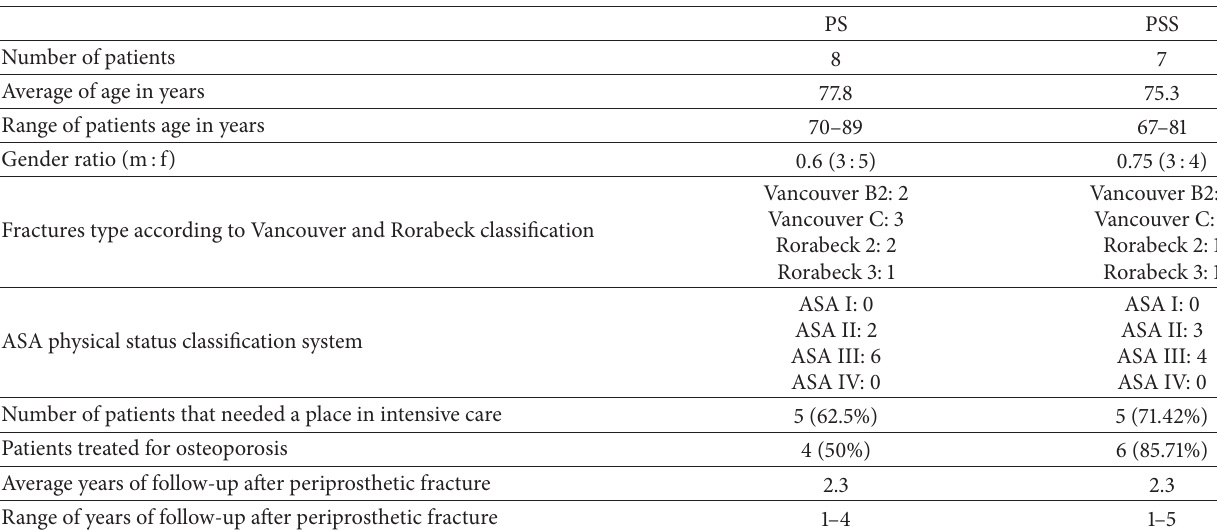
Table 1: Description of population.